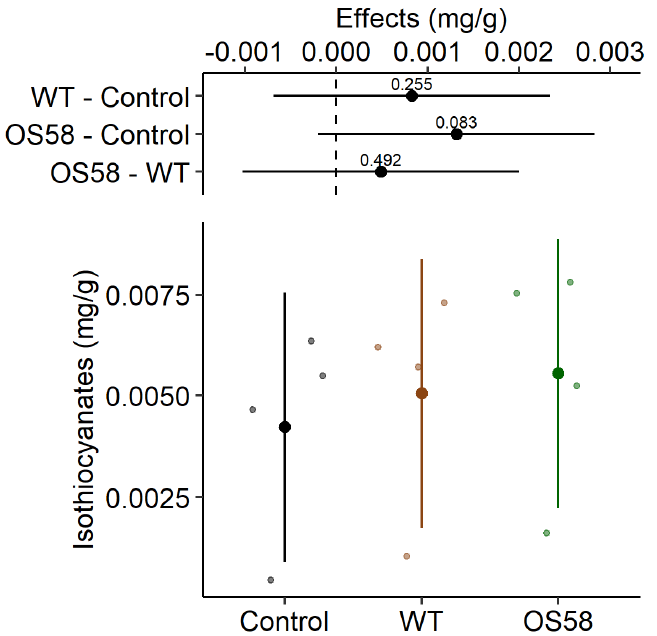
Figure 5. The isothiocyanates content (calculated as mg per gram of fresh cauliflowers) is reported for the Control, WT, and OS58 groups. A detailed description of these types of plots is provided in Figure 2.